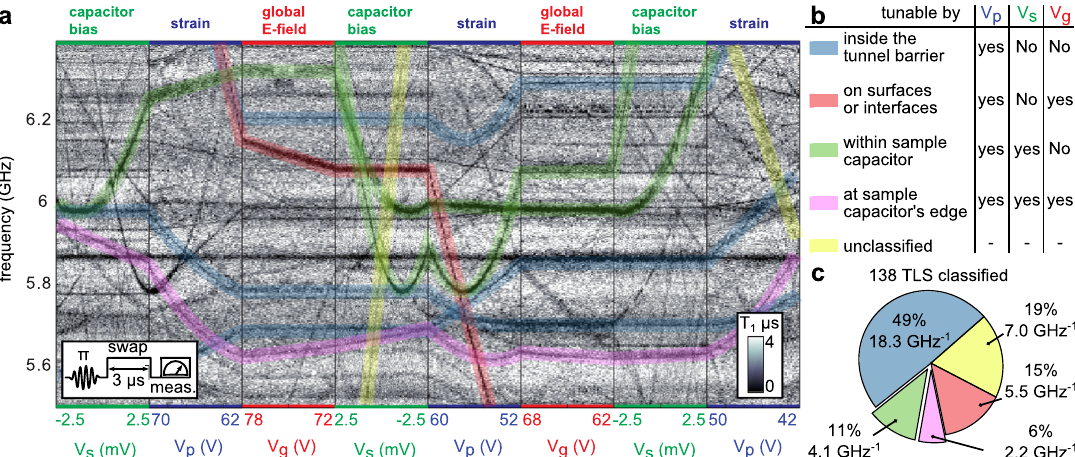
Fig. 2 Defect spectroscopy. a Typical data recorded with the swap spectroscopy protocol (see left inset). Each dark trace indicates a reduction in the qubit ’ s T 1 time due to resonant coupling to an individual TLS. The response of TLS to control parameters (such as physical strain, global E- fi eld, and the E- fi eld inside the sample capacitor) allows one to identify the possible location of the TLS as listed in the table in panel b . Some exemplary TLS are highlighted with colored lines, where yellow lines indicate TLS that could not be classi fi ed since they were visible in only a single segment. While V g and V p were continually reduced, V s was ramped alternatingly up or down with the amplitude limited to ∣ V s ∣ < 2.5mV to avoid heating of the attenuators in the bias line. c The resulting density (detected TLS per GHz bandwidth) of 138 TLS observed in measurements on two identical